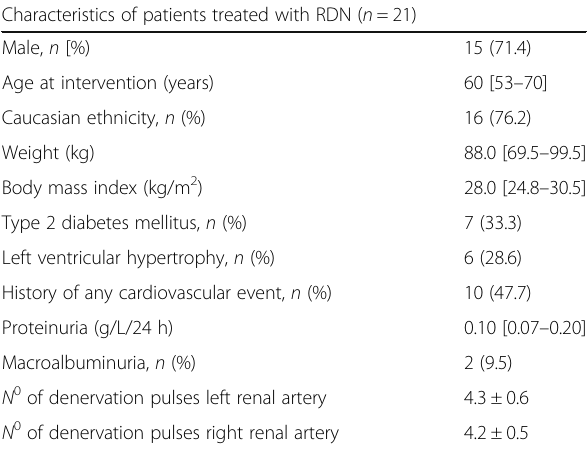
Table 1 Characteristics of patients treated with RDN ( n = 21) Characteristics of patients treated with RDN ( n =